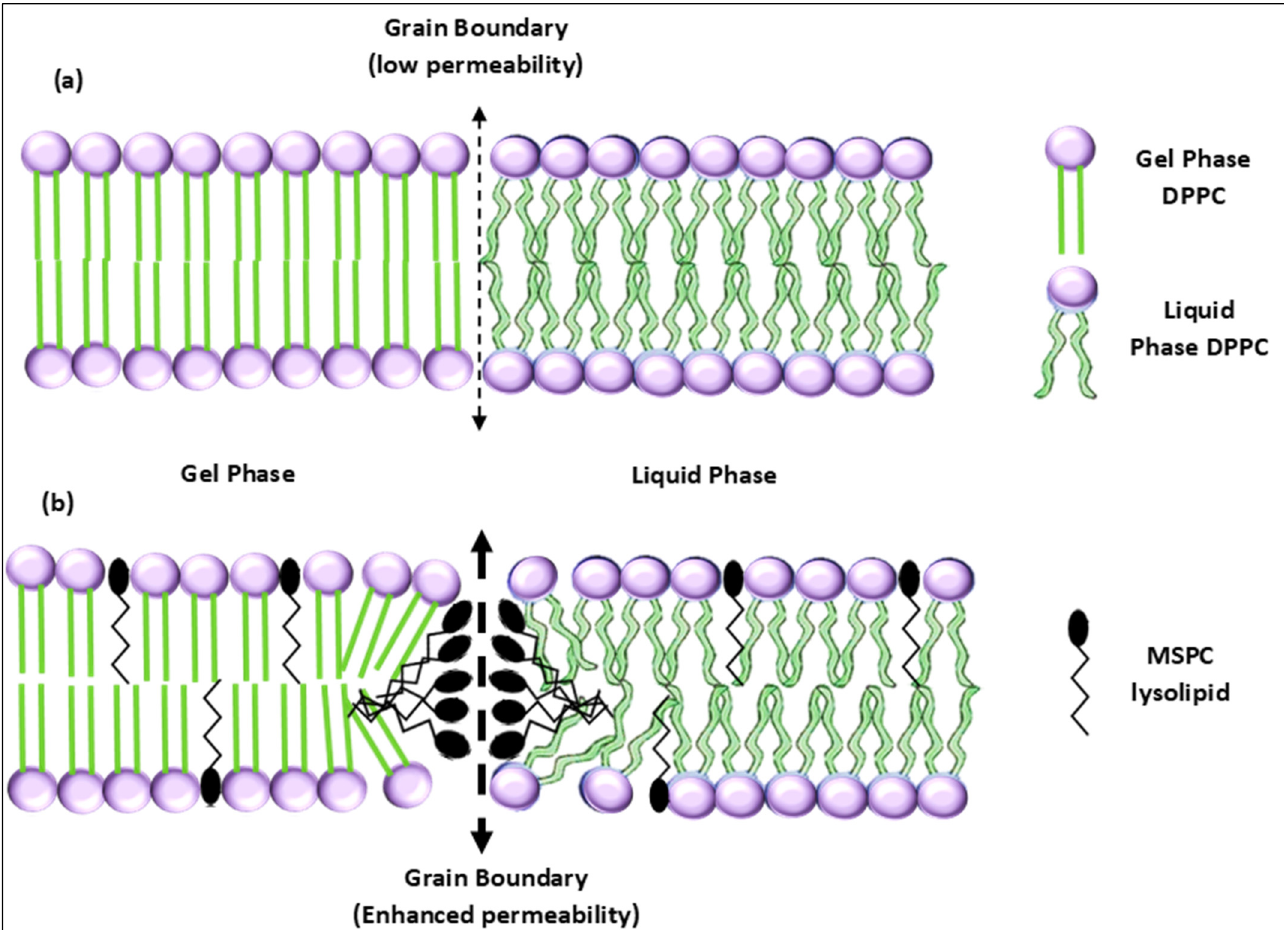
Figure 5. A schematic showing phase transition of the lipid bilayer in ( a ) traditional TSLs and ( b ) LTSLs. Inclusion of the lysolipid MSPC increases the membrane permeability due to introducing planar vacancy defects.